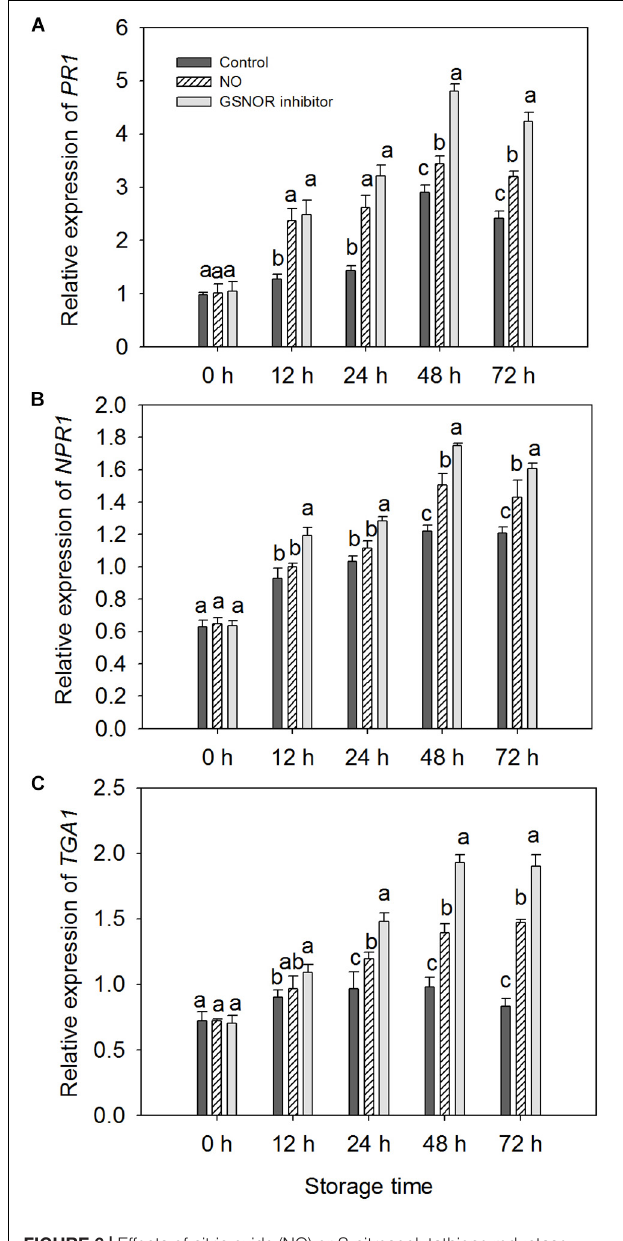
FIGURE 6 | Effects of nitric oxide (NO) or S -nitrosoglutathione reductase (GSNOR) inhibitor treatment on (A) PR1 , (B) NPR1 , and (C) TGA1 gene expression, determined by real-time qPCR. All experiments were run in triplicate with different complementary DNAs (cDNAs) synthesized from six biological replicates. Vertical bars represent the standard deviation of the means ( n = 6). Different letters represent significant differences ( P < 0.05) according to least significant difference (LSD)